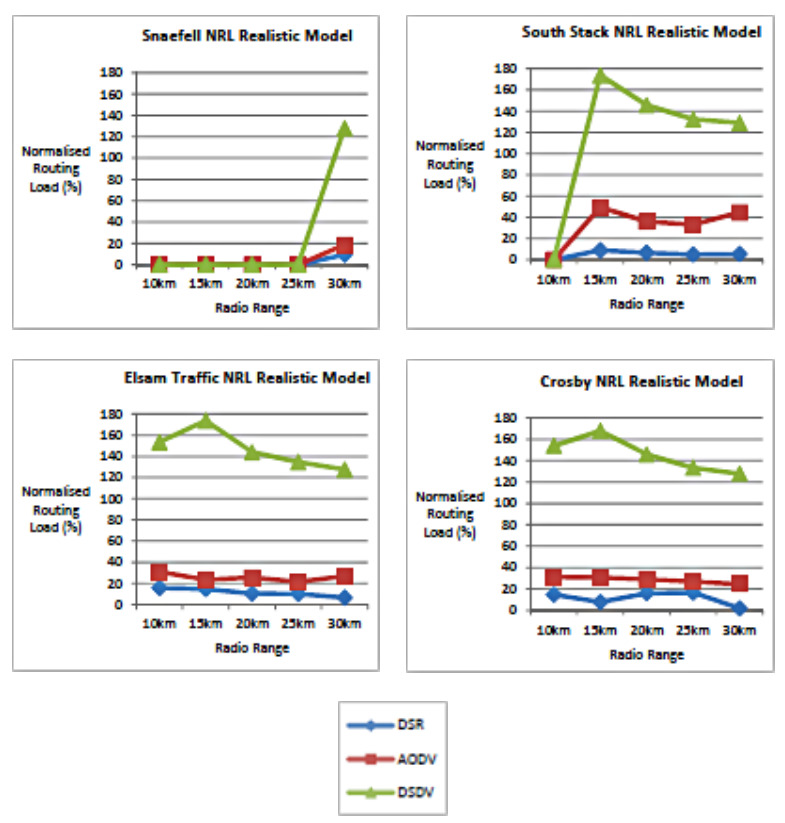
Figure 15. Realistic Shipping Model with Normalized Routing Load.